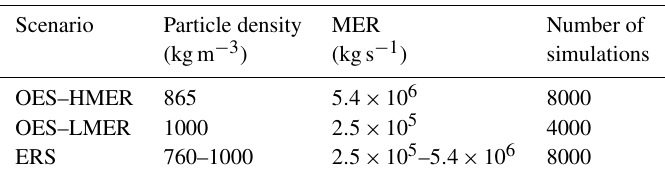
Table B3. Input parameters for hazard analysis scenarios, each run with 500 particles. For all simulations vent was set to the New Southeast Crater, particle size was 5cm and drag coefficient values were k S = 1 . 003803782 and k N = 1 .